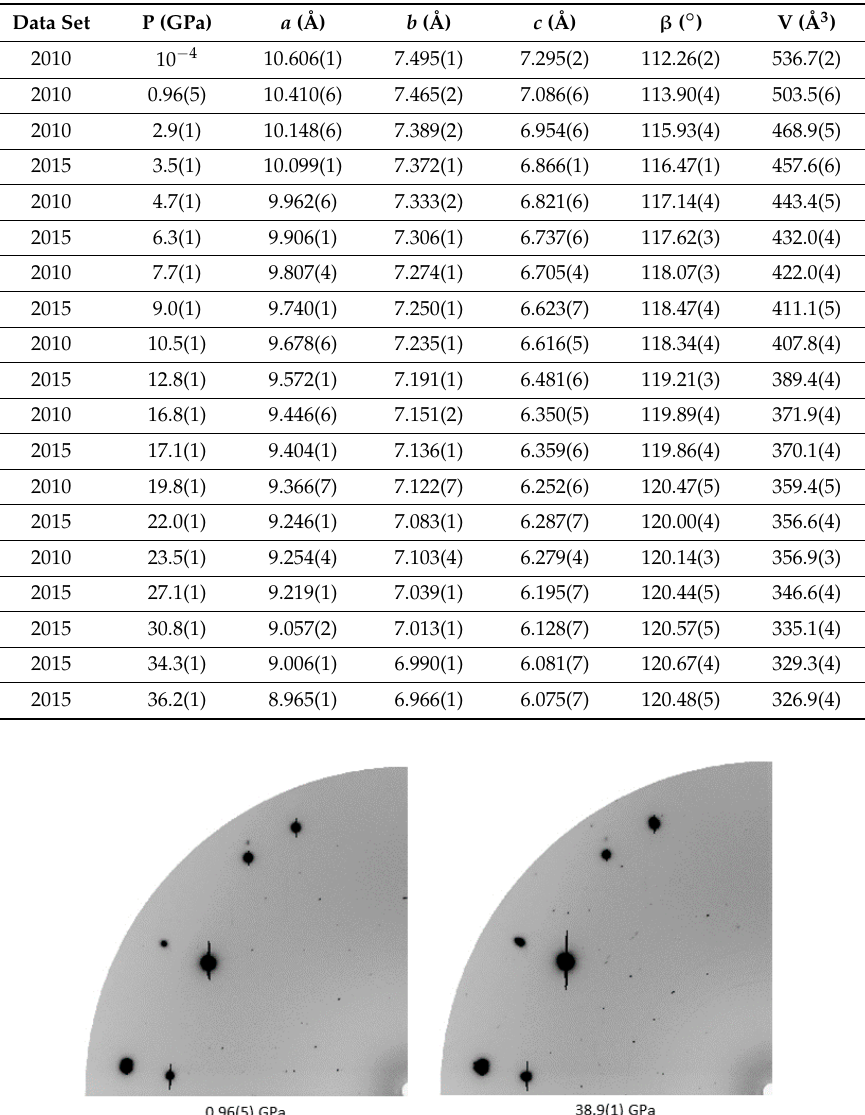
Table 2. Unit cell parameters as a function of pressure. 2010 data were collected in Ne, 2015 data in He.